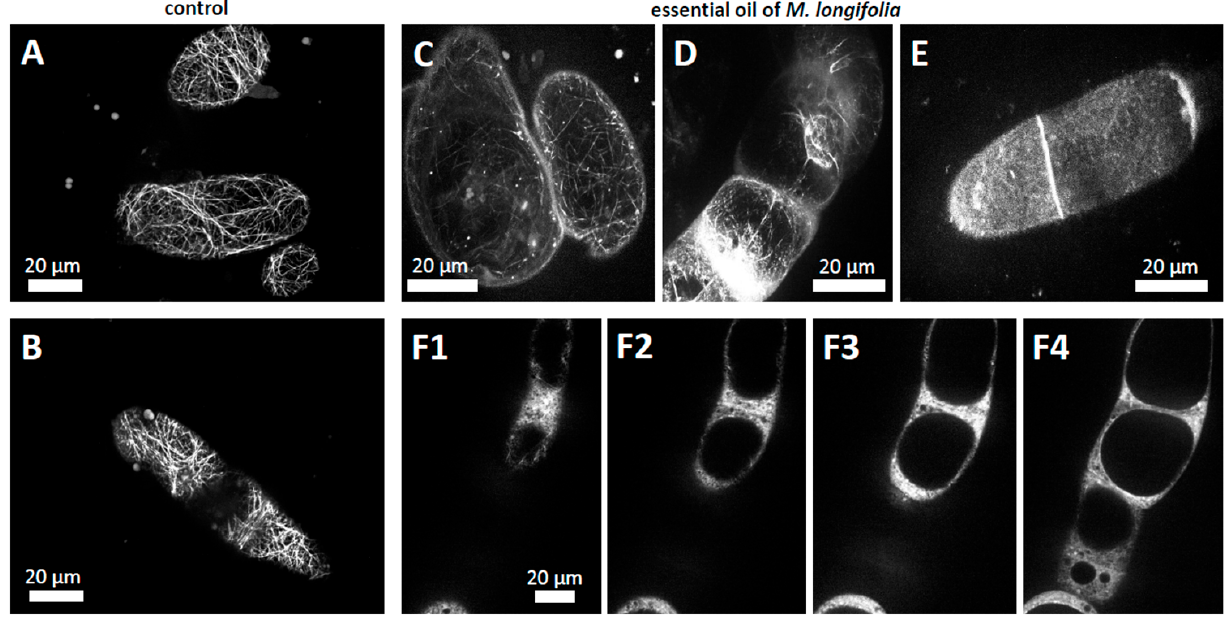
Figure 6. E ff ect of essential oil from M. longifolia on actin fi laments in tobacco BY-2 cells visualised by the marker FABD2-GFP and spinning disc confocal microscopy. ( A , B ) Representative control cells after 30 min of treatment with the solvent control (0.1 v / v % n -hexane). ( C – F ) Representative cells after 30 min of treatment with essential oil of M. longifolia (0.1% v / v ). ( A – E ) Geometric projection of z-stacks collected across the cell. ( F1 – F4 ) Individual sections collected from the cell periphery ( F1 ) through the cell centre ( F4 ). All treatments occurred through the gas phase, without physical contact between the cells and solvent or essential oil, respectively. actin filaments observed under the same conditions.